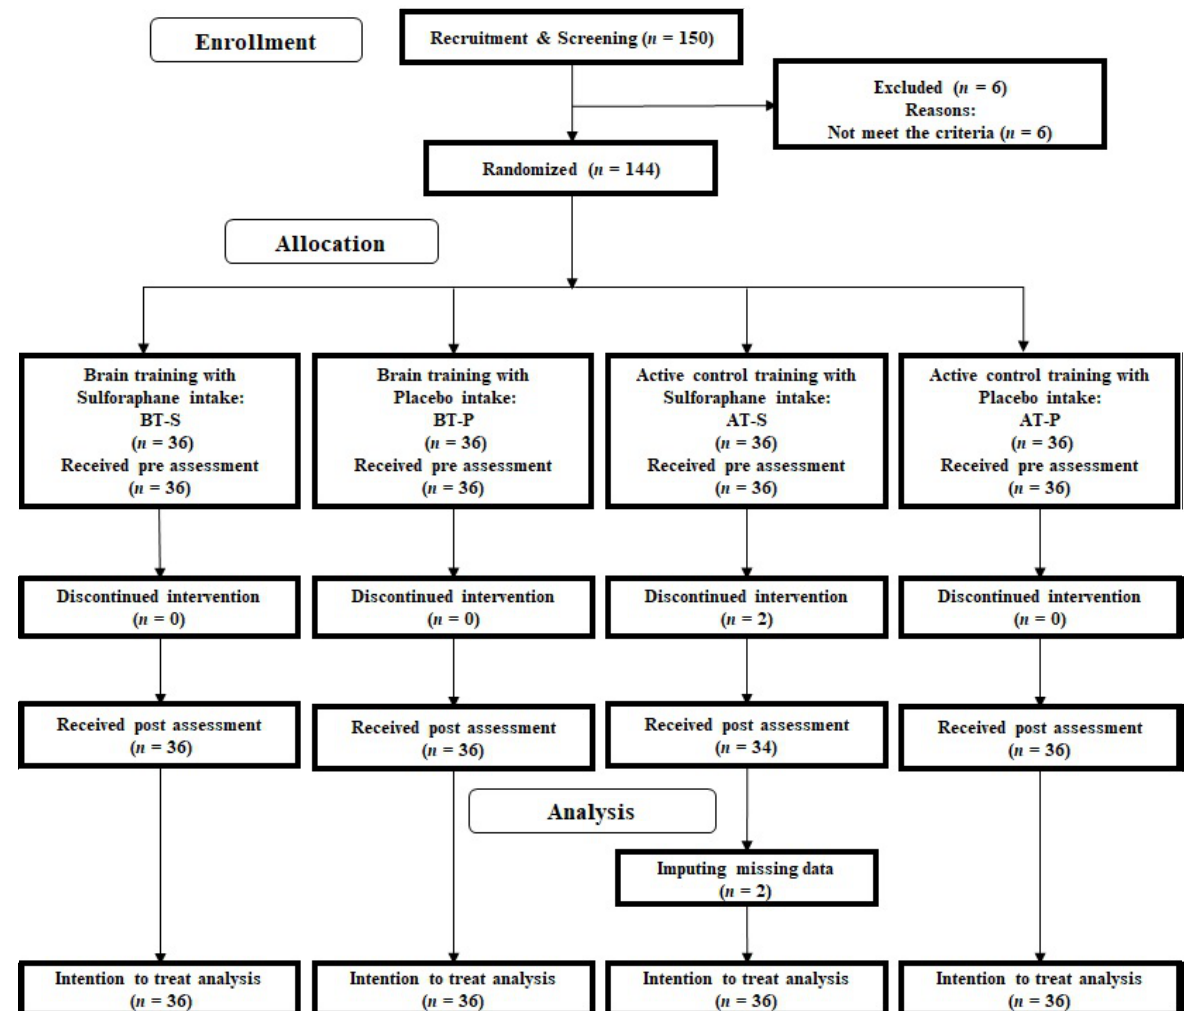
Figure 1. CONSORT diagram. BT: Brain training, AT: active control training, SFN: sulforaphane, P: